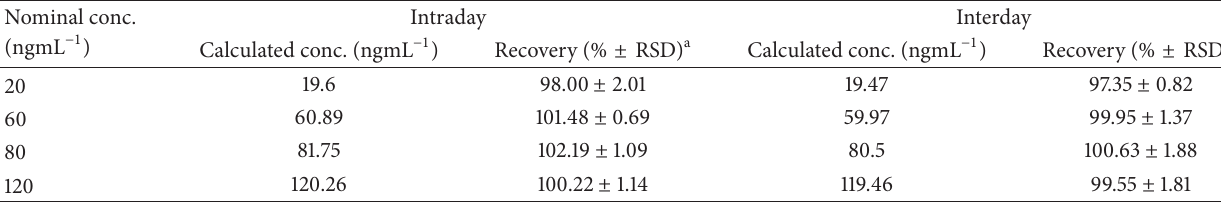
Table 3: Intra- and interday precision and accuracy for PTB determination by the adopted analytical method. Nominal conc.